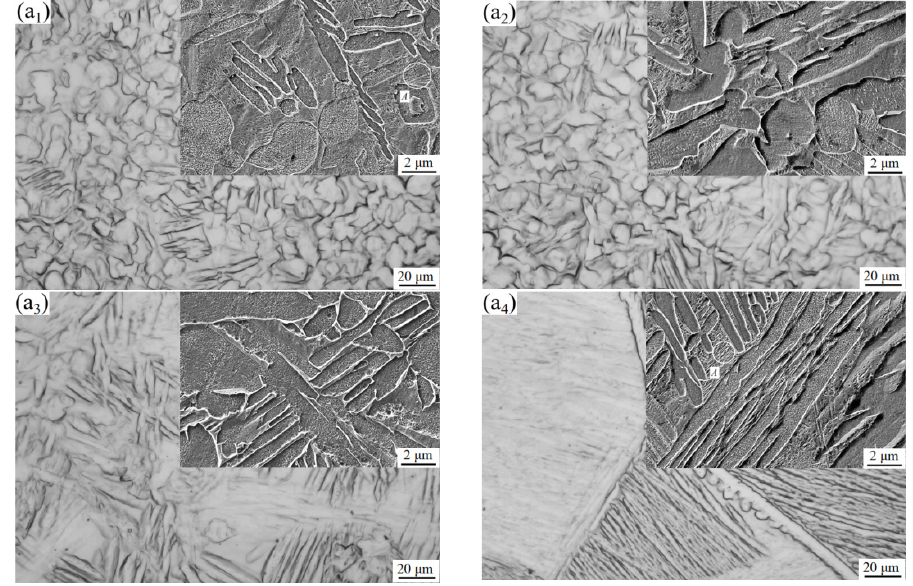
Figure 5. Microstructure after BASC heat treatment: ( a 1 ) 900 °C; ( a 2 ) 920 °C; ( a 3 ) 940 °C; ( a 4 ) 960 °C. When the BA temperature is in the two-phase region, before the start of the SC phase, there is a part of the α phase in the microstructure, and the β → α phase transition occurs during the SC phase. At this time, there are two possibilities for the precipitated α phase. One is that the precipitated α phase nucleates and grows at the β grain boundary, and the other is that the precipitated α phase nucleates and grows at the interface of the original α phase and is connected with the original α phase [14]. The orientation of the α phase precipitated at the original α interface is different from that of the original α phase, and its size is related to the cooling rate. When the cooling rate is faster, the morphology is mainly needle like. When the cooling rate is slower, the morphology is mainly plate